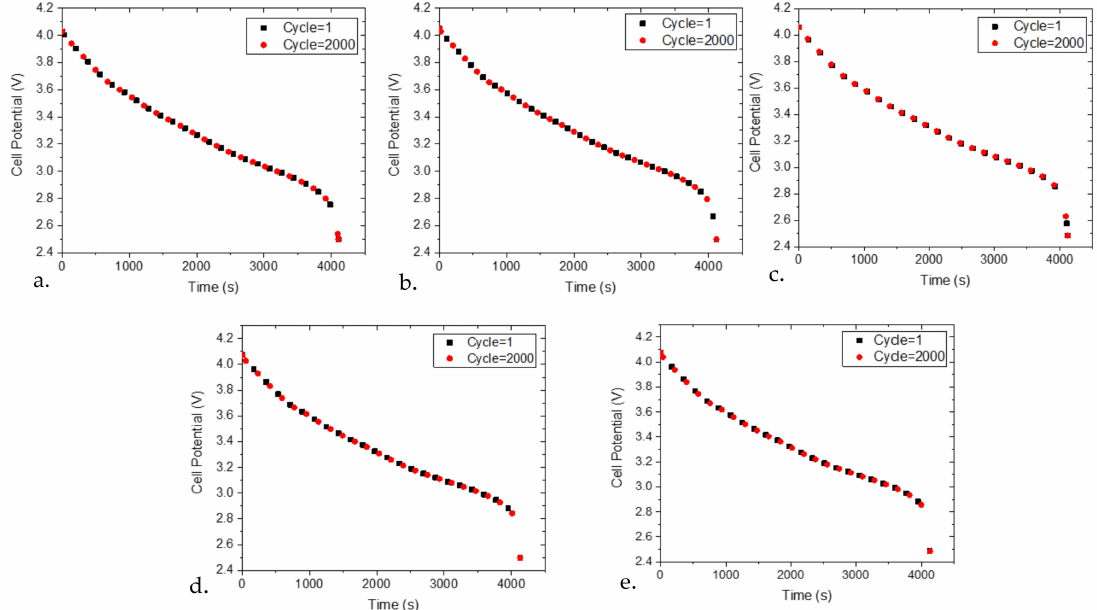
Figure 2. Simulated discharge curves comparing NCA cathodes for the first and 2000th cycle when the Si anode particle sizes are ( a ) 4 µ m, ( b ) 2 µ m, ( c ) 1 µ m, ( d ) 150 nm, ( e ) 100